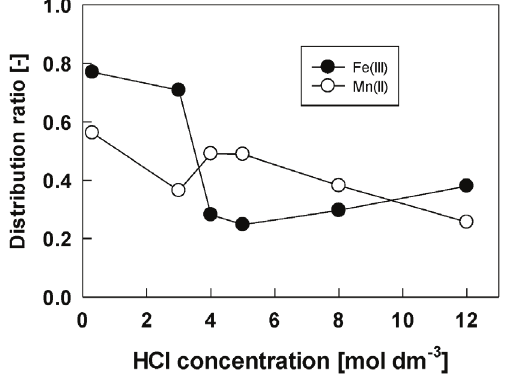
Fig. 5 – Effect of HCl concentration on distribution ratio of Fe(III) and Mn(II) at various ratios of 50 % IL solution: 50 % PEG solution: metal solution: 2: 1: